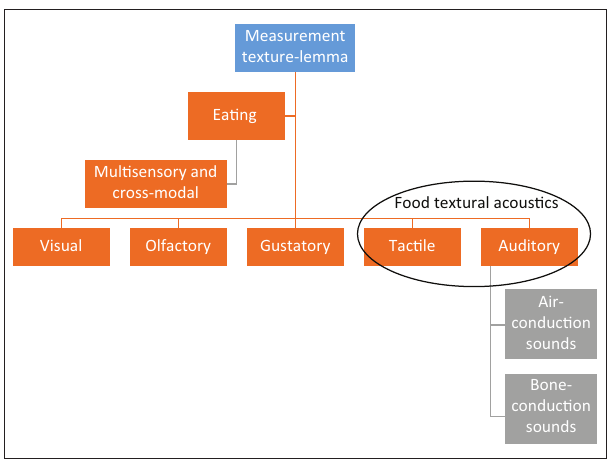
FIGURE 3: Diagram showing the complexity of eating and studying food textural